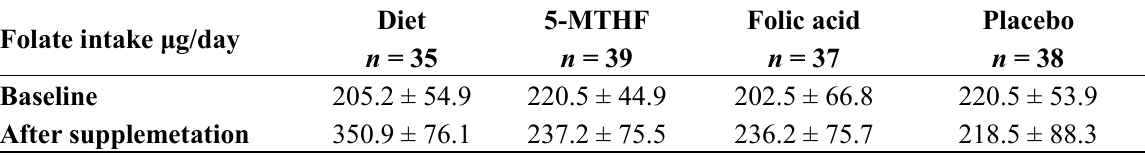
Table S1. Food folate intake at baseline and after supplementation, by treatment